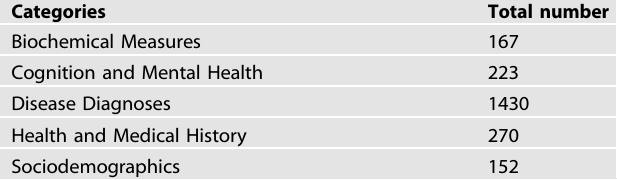
Table 1. Total number of phenotypes analyzed by